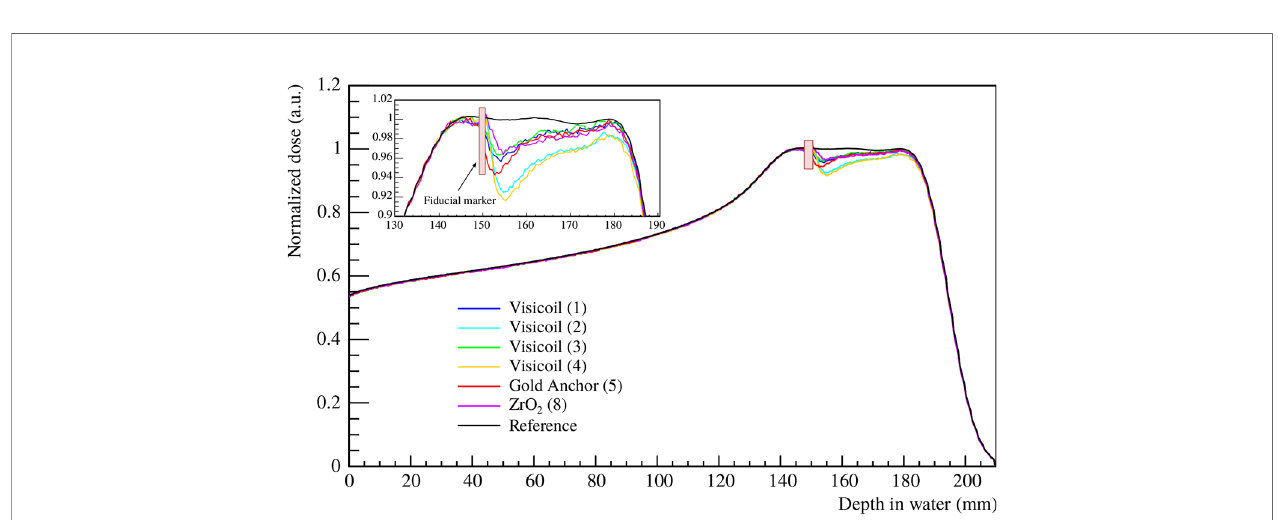
FIGURE 13 | SOBP created with protons in water, covering 5 cm in depth. The depth – dose pro fi les were extracted from the central line of the dose maps. The black line shows the reference measurement without marker, while the colored lines show the SOBP with a fi ducial marker placed at 15cm depth. The FLUKA simulations were performed for 6 fi ducial markers ( Table 1 ).